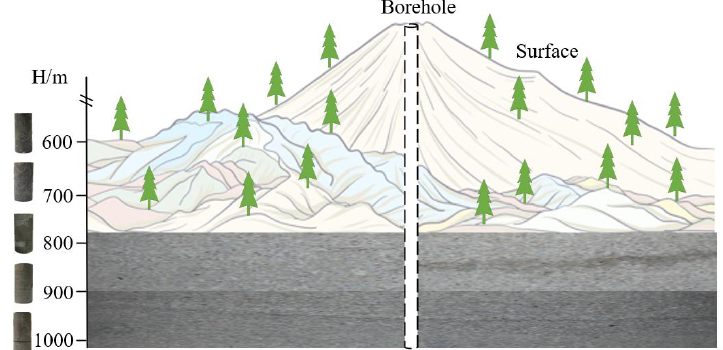
Figure 1. Schematic diagram of the limestone rock sampling.